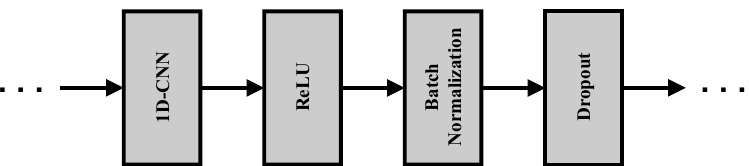
Figure 7. Composition of the convolutional blocks of the CNN